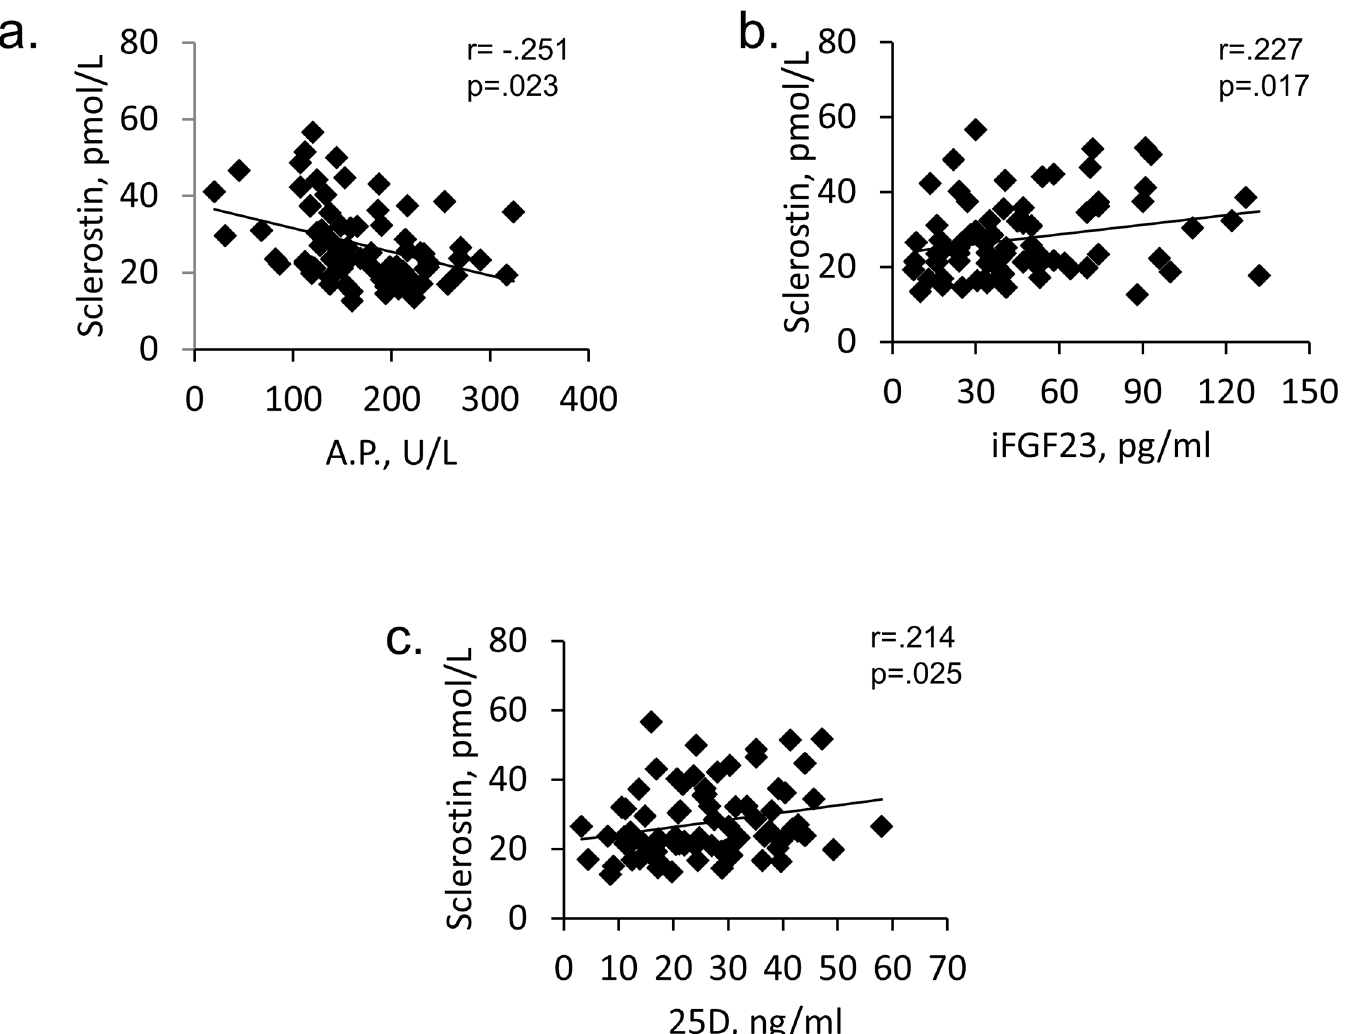
Fig 2. Correlation tests of Sclerostin. Correlationtests with ( a) AP, AlkalinePhosphatase; (b) iFGF23, intact Fibroblast Growth Factor 23; (c) 25D, 25-hydroxyvitaminD.